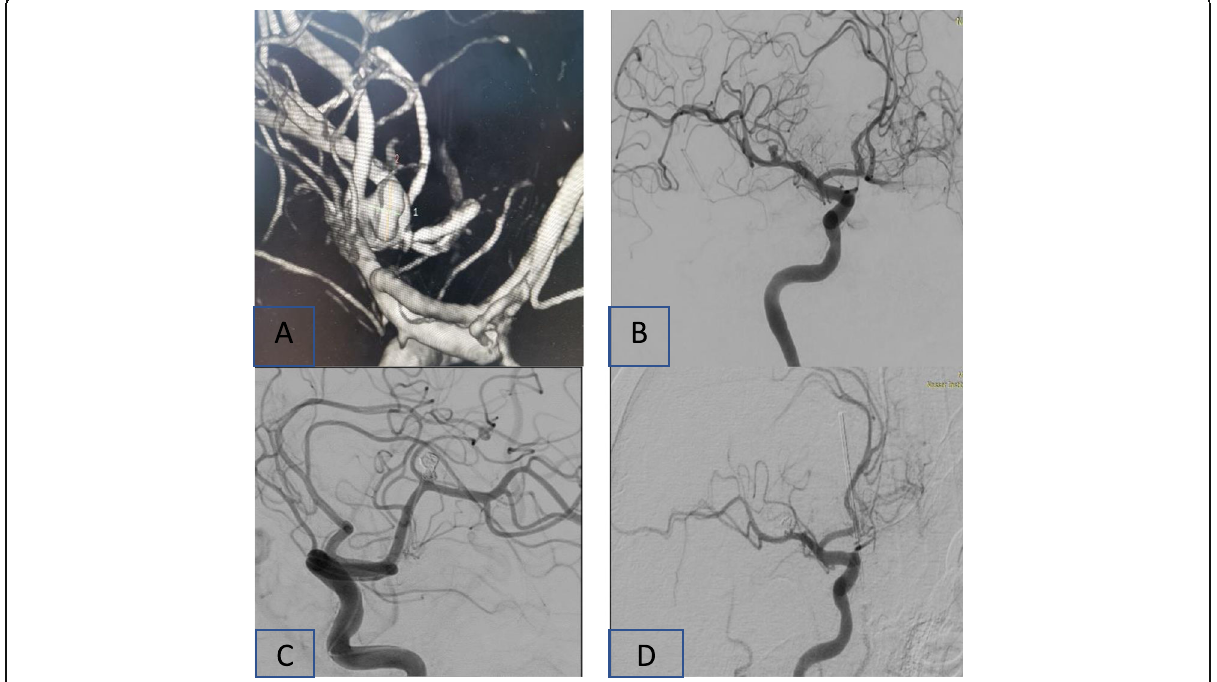
Fig. 2 MCA bifurcation aneurysm with complete total occlusion with simple coiling. A 3D reconstructed image of the aneurysm before treatment. B 2D, AP view of the aneurysm before treatment. C Lateral view, intra-procedural, with micro catheter coil deployment.